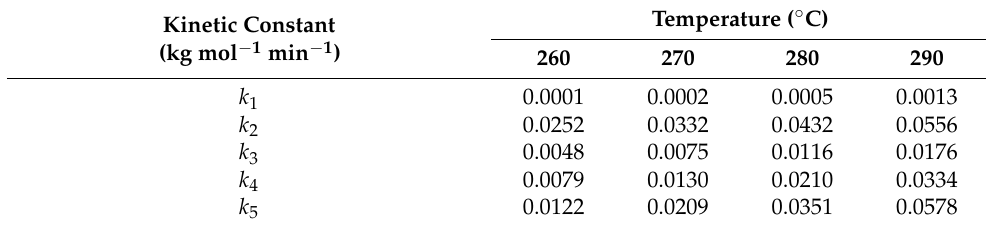
Table 2. Kinetic constants of esterification of rosin and